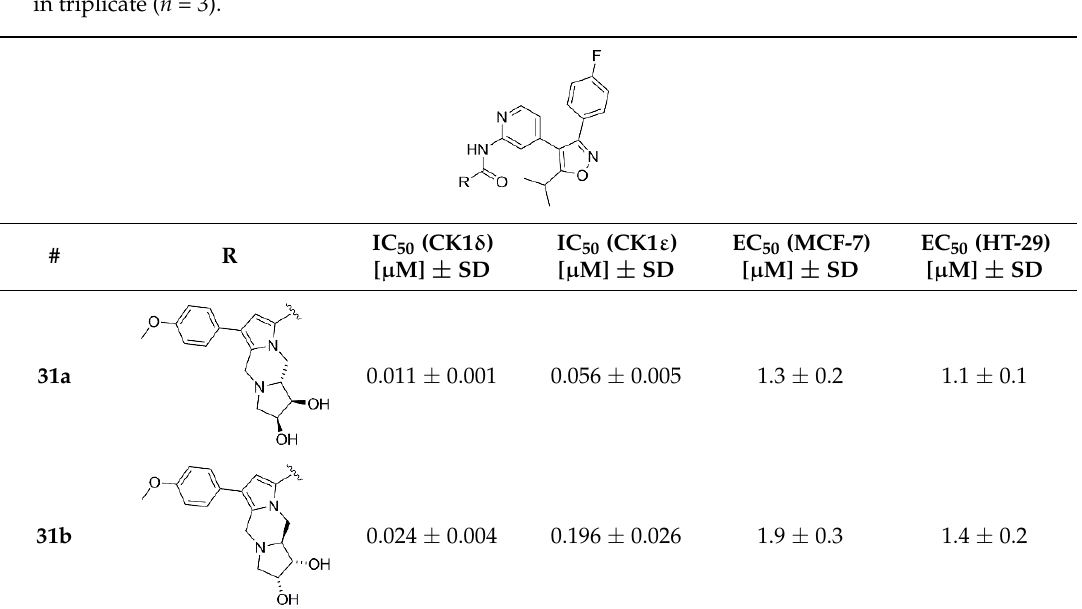
Table 3. Biological activity of compound 31a and 31b in in ‐ vitro kinase assays (CK1 δ and CK1 ε ) and cellular assays (MCF ‐ 7 ‐ and HT ‐ 29). Results are presented as mean ± SD from experiments performed in triplicate ( n = 3).